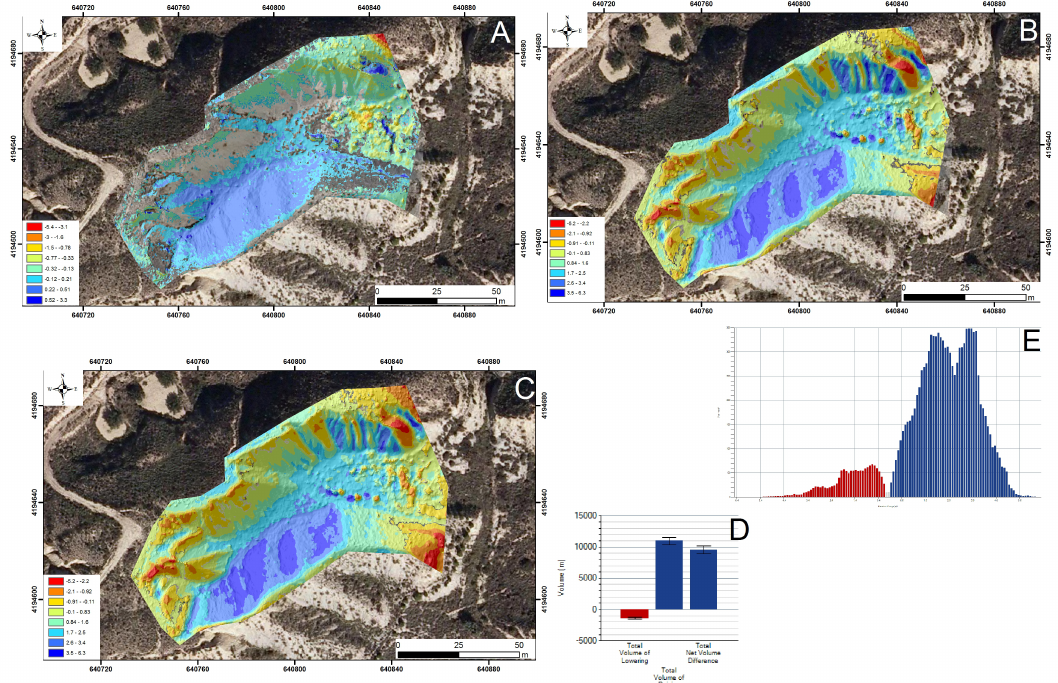
Figure 11. Bank gully (B.G-2)( A ) DoD Mission I and II. ( B ) DoD Mission II and III. ( C ) DoD Mission I and III. ( D )Graphe of DoD volume. ( E ) Bar chart of DoD volume change distribution (erosion volume in red, deposition volume in